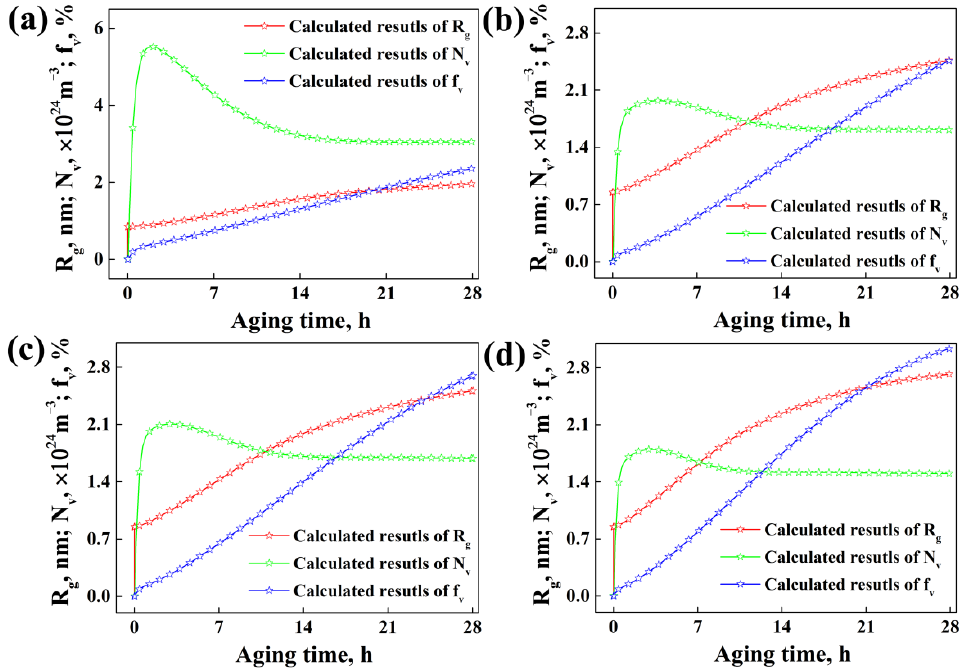
Figure 8. Average radius, number density and volume fraction of precipitates during aging for the alloy samples with different strains: ( a ) 0; ( b ) 0.10; ( c ) 0.15; ( d ) 0.20.